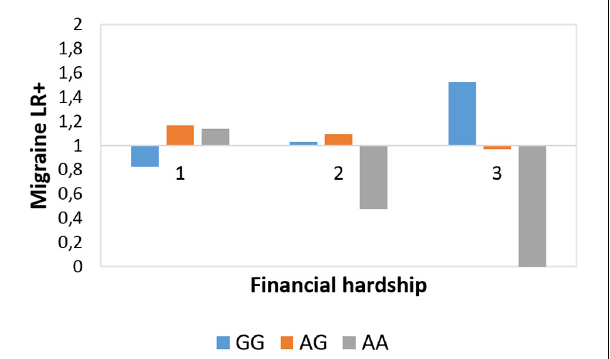
FIGURE 4 | Rs10462028 × financial hardship effect on migraineID in the Manchester subsample. The interaction effect between CLOCK rs10462028 and financial hardship on migraineID in the Manchester subsample is shown. FINANC, financial hardship; LR+, positive likelihood ratio. Number of cases in FINANC_1 ( living very/quite comfortably ) group: GG = 306, AG = 308, AA = 75. Number of cases in FINANC_2 ( just getting by ) group: GG = 188, AG = 165, AA = 56. Number of cases in FINANC_3 ( finding it difficult/not able to make ends meet ) group: GG = 79, AG = 81, AA =